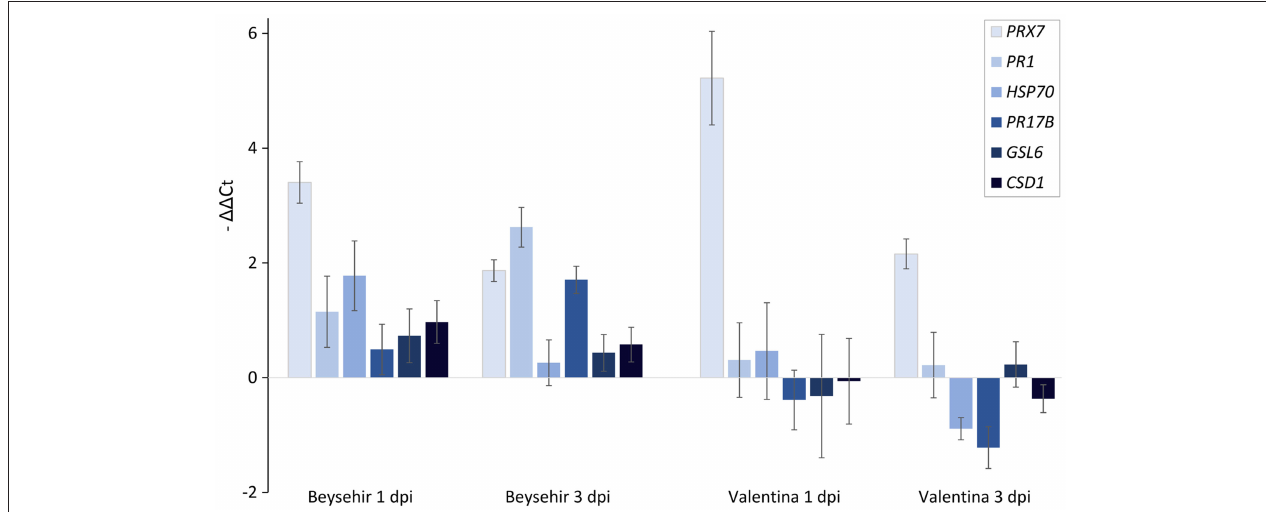
FIGURE 6 | Microbiome effect on defense gene expression of the cultivar Beysehir that showed microbiome-induced resistance to P. neglectus , and the cultivar Valentina that did not respond to the microbiome ( Figure 3 ), 1 day and 3 days after inoculation of P. neglectus . RNA was extracted, reverse-transcribed, and quantified in real-time PCR. Transcript levels were determined for roots with the inoculated microbiome, relative to expression in noninoculated roots, both normalized to the expression of the control gene UBQ according to the – 11 C t method. Error bars represent SE ( n = 6).